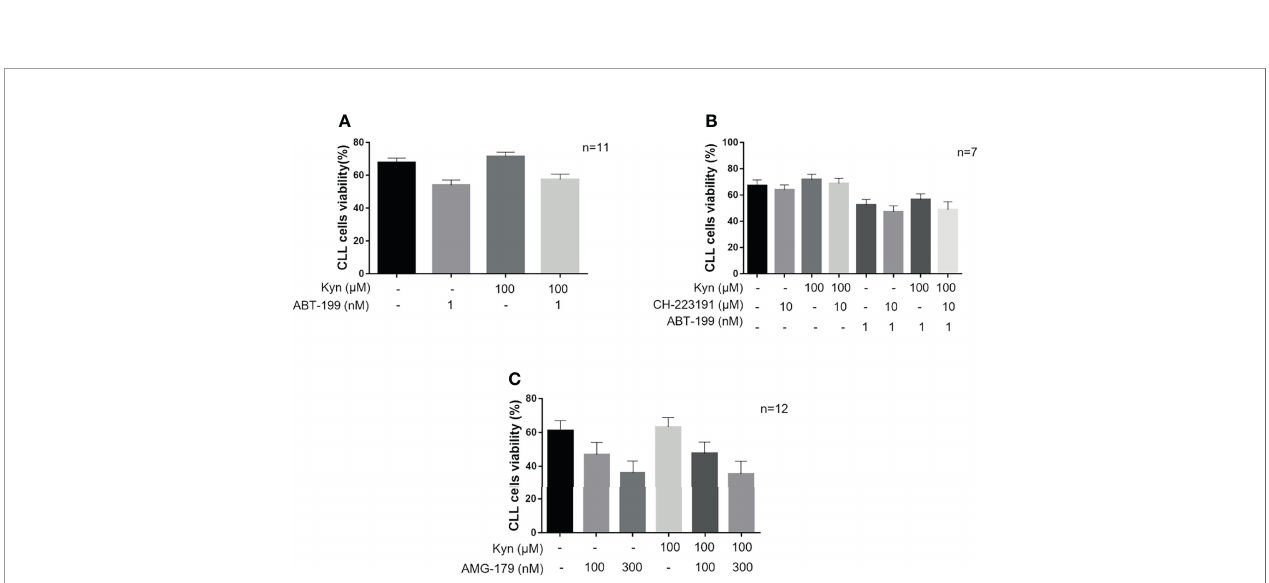
FIGURE 5 | The activity of IDO1/Kyn/AHR axis impairs CLL cells response to ABT-199. (A) Histograms show comparison on viability rate of CLL cells treated with 1 nM ABT-199 for 5 h after overnight stimulation with 100 µM Kyn (repeated-measure two-way ANOVA with Kyn and CH-223191 treatment groups as the two factors; n = 11). (B) CLL cells were pretreated for 90 min with 10 µM CH-223191 and cultured overnight with Kyn. Then, 1 nM ABT-199 was added to culture for 5 h prior to cell viability assessment. Histograms illustrate the synergistic effect of CH-223191 with ABT-199 in CLL cells (repeated-measure three-way ANOVA with Kyn, ABT- 199, and CH-223191 treatment groups as the three factors; n = 7). (C) CD19+ cells were cultured overnight with 100 µM Kyn, and then 100 or 300 nM AMG-176 was added to culture for 5 h. Cell viability was measured and depicted in histograms (repeated-measure two-way ANOVA with Kyn and AMG-176 treatment groups as the two factors; n =